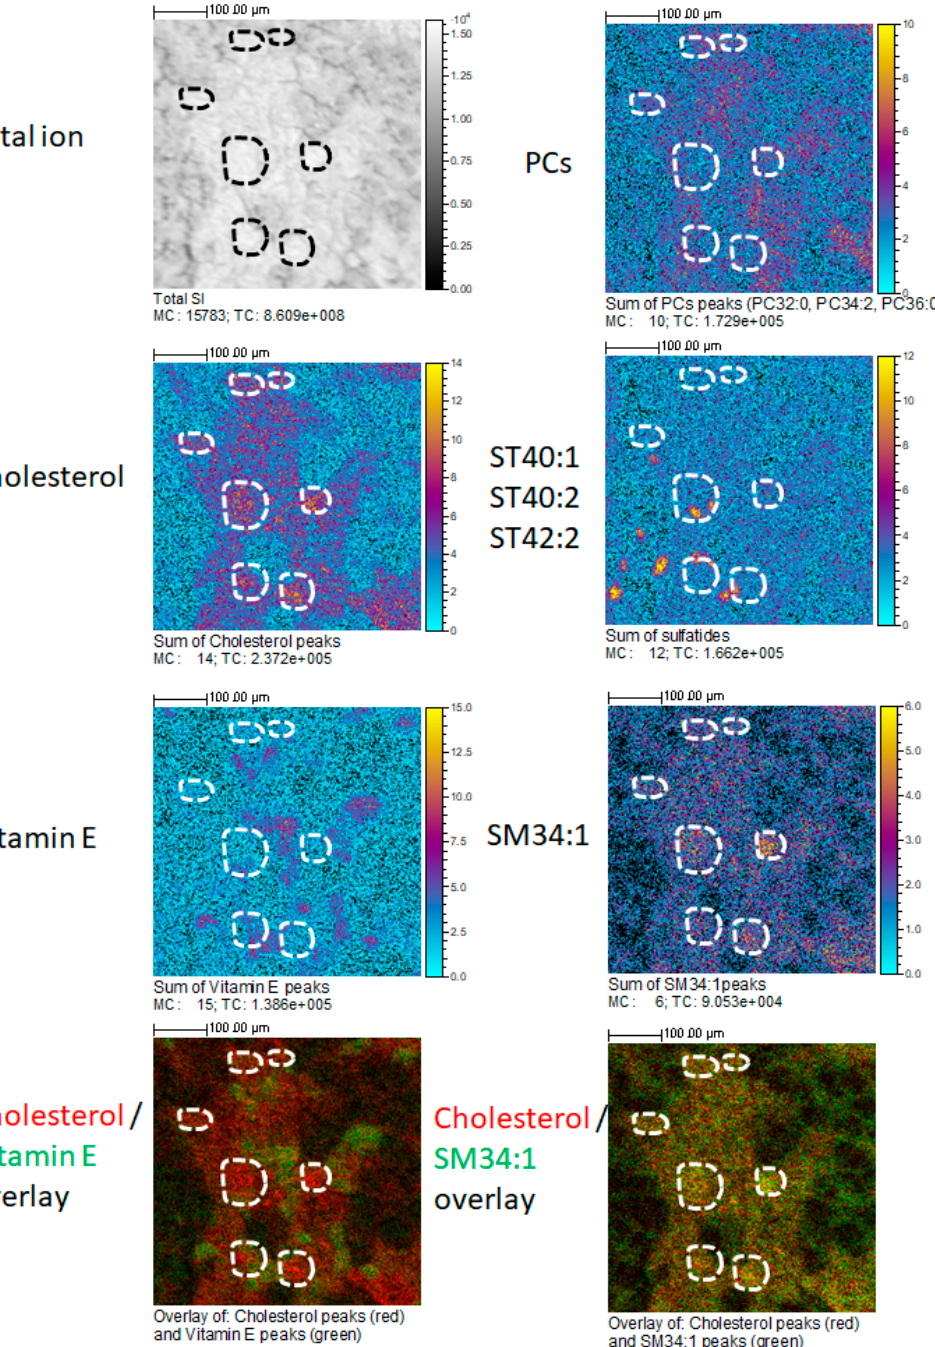
Figure 1. Representative section of a mouse kidney cortex, showing the spatial distribution of several ions (sum of cholesterol peaks, sum of α -tocopherol peaks, sum of phosphatidylcholine (PC) peaks, sum of sulfatides (ST 40:1, ST 40:2, ST 40:3), sum of sphingomyelin (SM) 34:1 peaks, and the total ion current) at a spatial resolution of 2 µ m per pixel. The scale on the right (gray levels or colors) indicates the relative abundance. Yellow or white denote higher abundances, while blue or black denote lower abundances. The two lower panels have been constructed by attributing one color (red or green) to each compound. Glomerular regions of interest are selected and depicted by the dashed white line. Bar length: 100 µ m. The name of the compound, the maximal number of counts in a pixel (MC), and the total number of counts (TC) are written below each